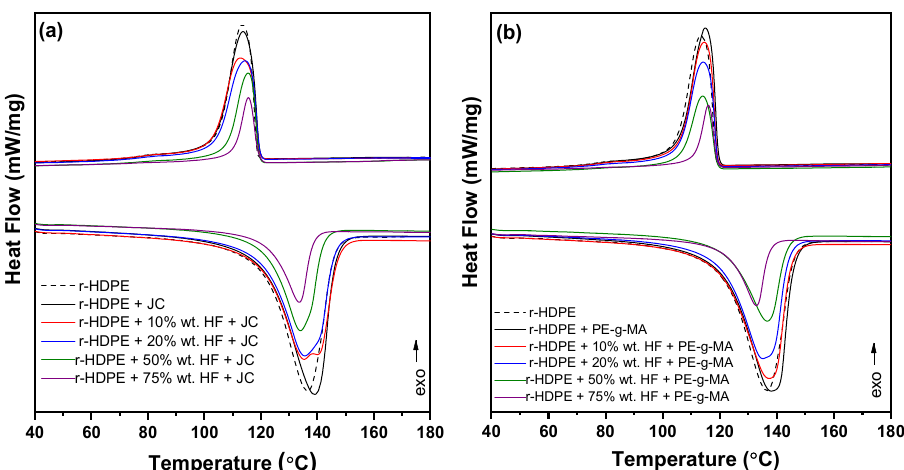
Figure 5. DSC thermograms of the prepared ( a ) recycled high-density polyethylene (r-HDPE) + hemp fibers (HF) + Joncryl (JC), and ( b ) r-HDPE + HF + polyethylene-grafted maleic anhydride (PE-g-MA) composite materials during the second heating and cooling scan. Table 2. Summary of the thermal values (melting and crystallization temperatures) for recycled